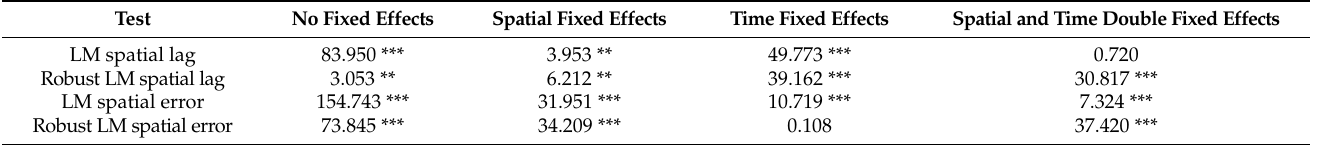
Table 3. Results of the Lagrange multiplier (LM) test and robust LM test.